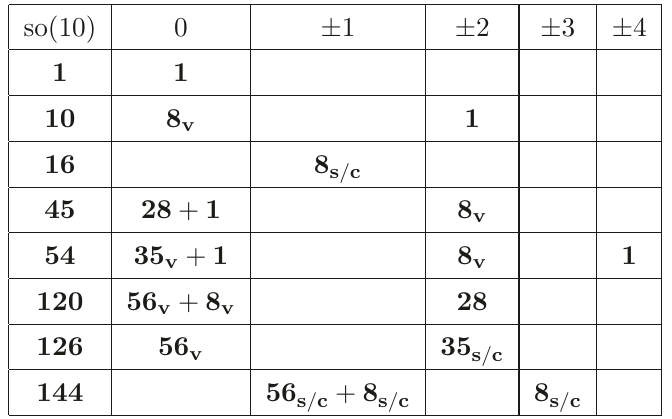
Table 6 . The decomposition of the so(10) representations to the subalgebra so(8) ×